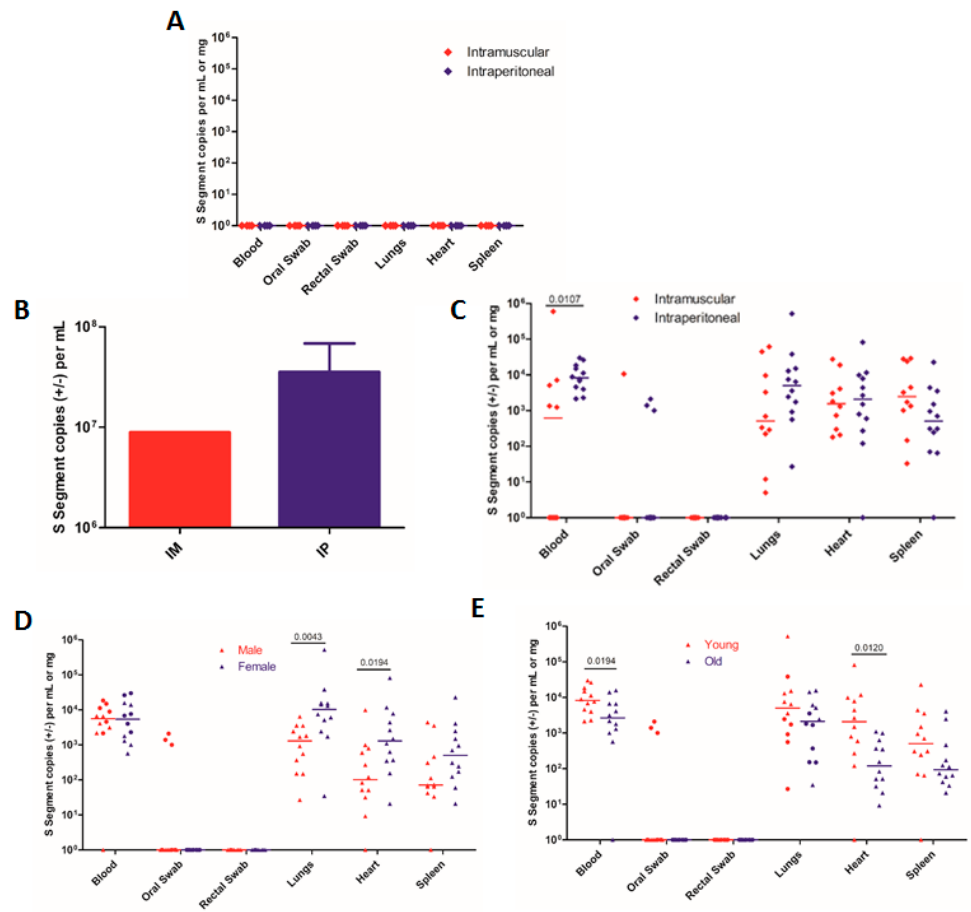
Figure 1. Sin Nombre virus (SNV) replication and shedding in male and female deer mice of different ages. ( A ) Groups of 1–2-month-old deer mice were inoculated with a VeroE6-adapted SNV. n = 4. ( B ) and ( C ) Groups of 10 (intramuscularly (IM) infected) or 12 (intraperitoneally (IP) infected) deer mice were infected with SNV, and S segment copies were detected in ( B ) pooled lung homogenates from each group for producing viral stocks or ( C ) each individual mouse to determine the amounts of viral replication and shedding. ( B ) 1 IM group was tested, and 3 IP groups were tested. ( D ) and ( E ) Comparison of replication and shedding seen in ( D ) male vs. female deer mice 10 days post-infection (circles: 1–2-month-old deer mice; triangles: 5–6-month-old deer mice) or ( E ) 1–2-month-old (young) vs. 5–6-month-old (old) deer mice 10 days post-infection (circles: male deer mice; triangles: female deer mice). The data shown are the mean + SEM ( B ) and medians ( C – E ) for each group. The numbers indicate the p value as assessed by a Mann–Whitney test.